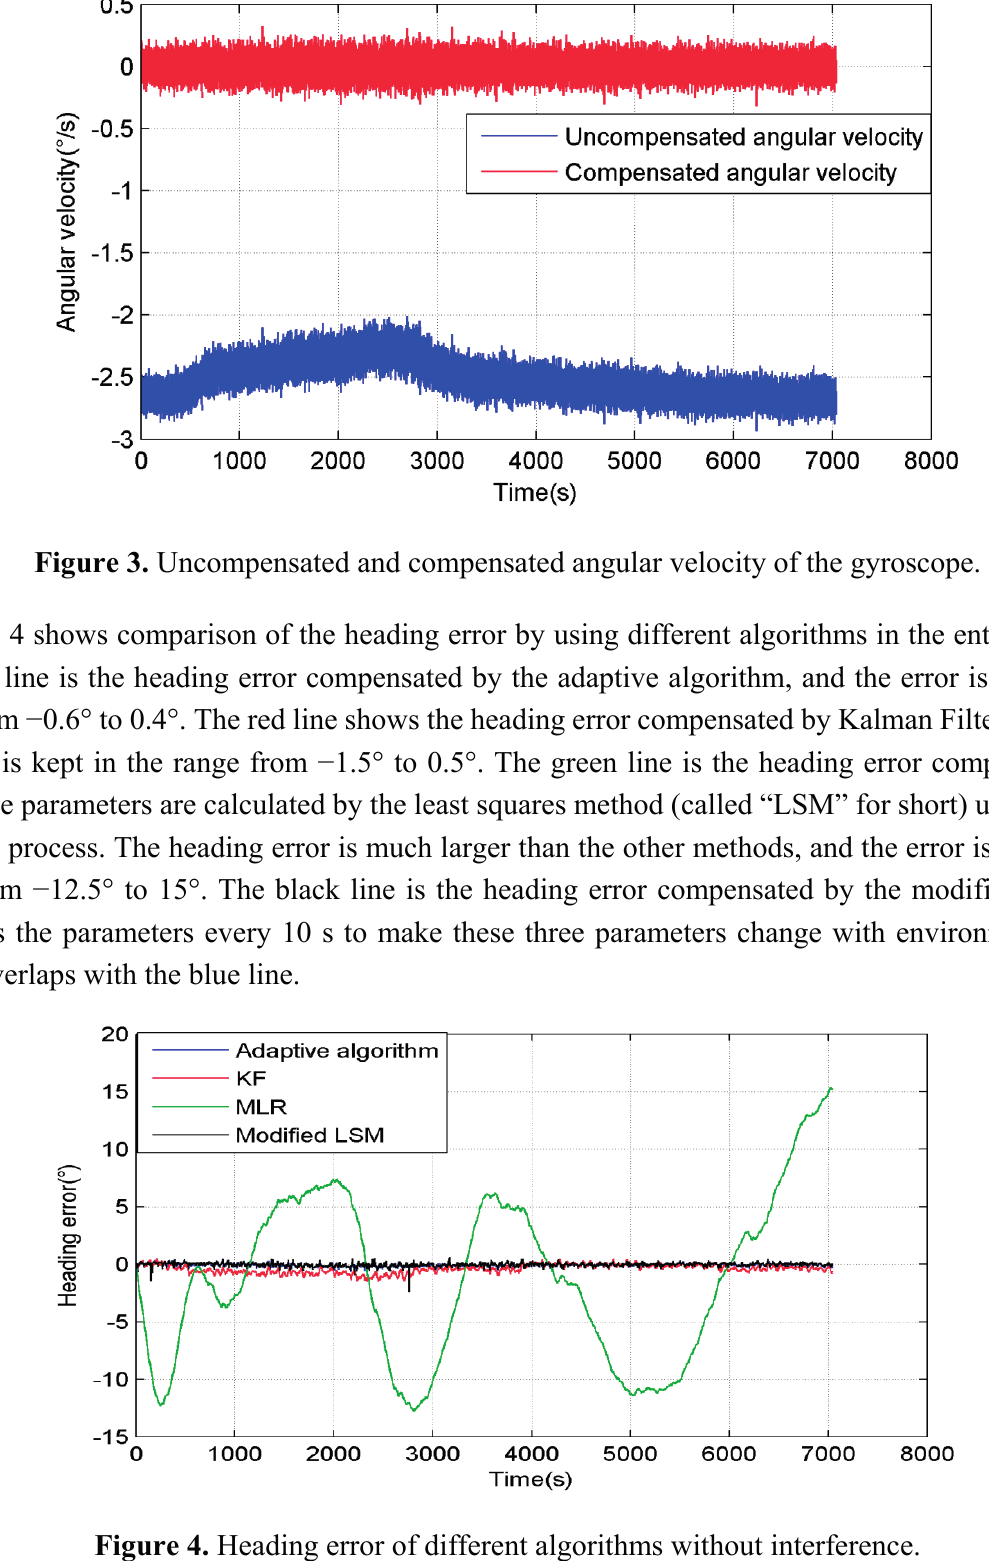
Figure 4. Heading error of different algorithms without